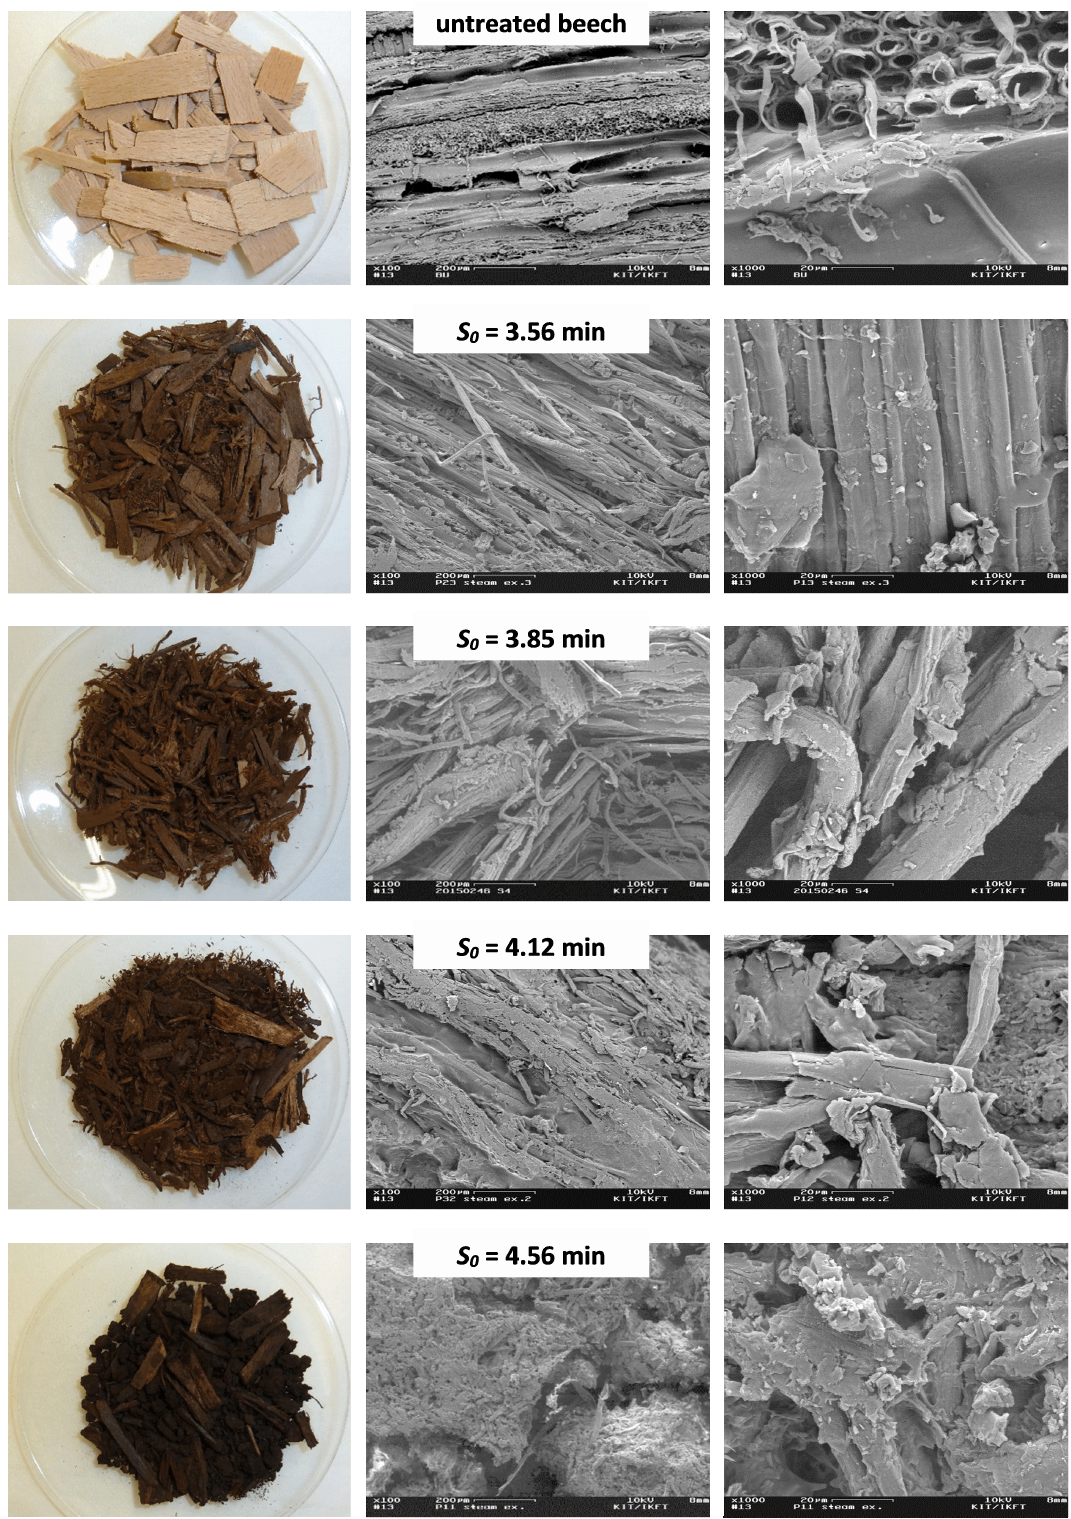
Figure 2. Beech wood and solid residues after steam explosion at different severity parameters S 0 , photographs ( left ), SEM images at 100× ( center ) and 1000× ( right ).